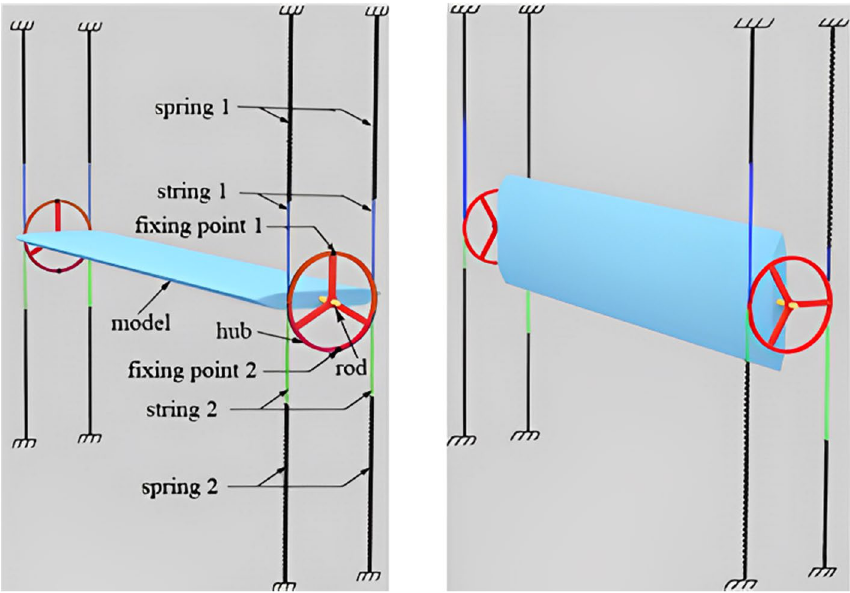
Fig. 24 Schematic diagram of the new device: a rotation angle